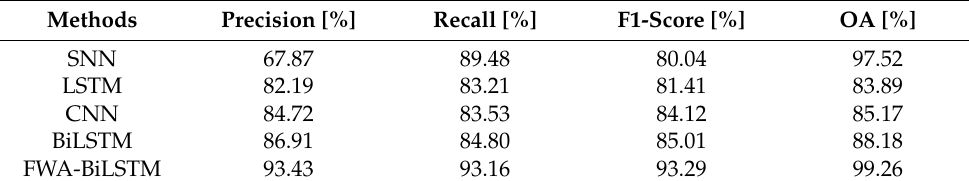
Table 2. Performance analysis of classifiers without attention layer on LEVIR-CD dataset.